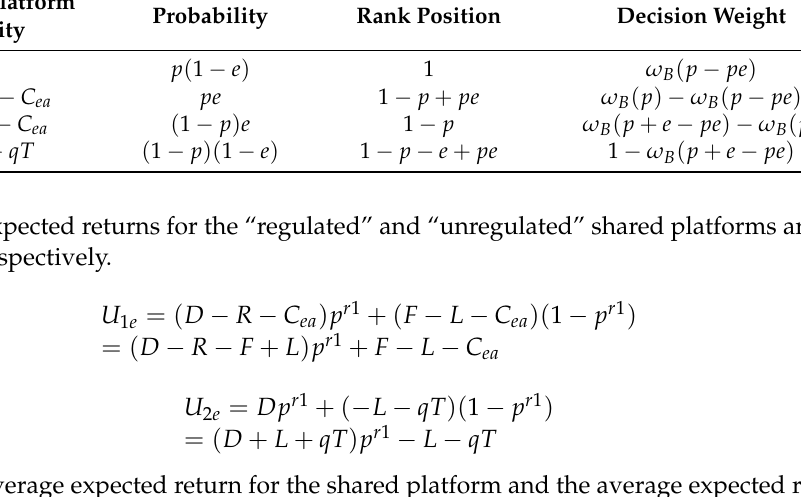
Table 4. Expected utility of the rank dependence of the shared platform considering emotion. Shared